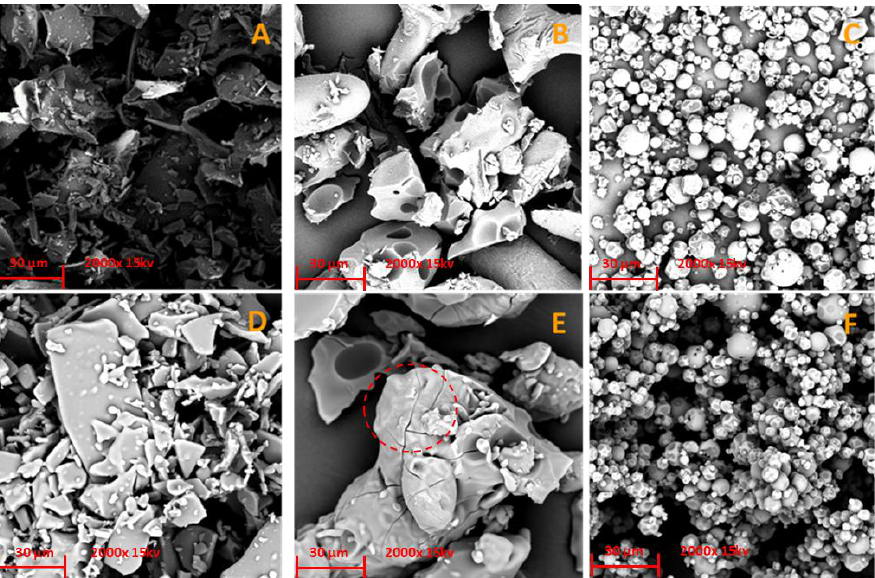
Figure 4. SEM images (2000 × ) of pure HP- α -CD ( A ), HP- β -CD ( B ) and HP- γ -CD ( C ) and the corresponding HP- α -CD/I 2 ( D ), HP- β -CD/I 2 ( E ) and HP- γ -CD/I 2 ( F ) prepared by SH